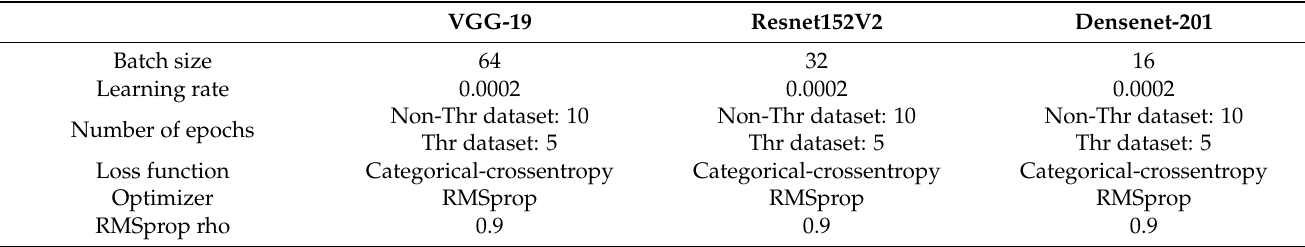
Table 2. CNN models hyperparameters tuning